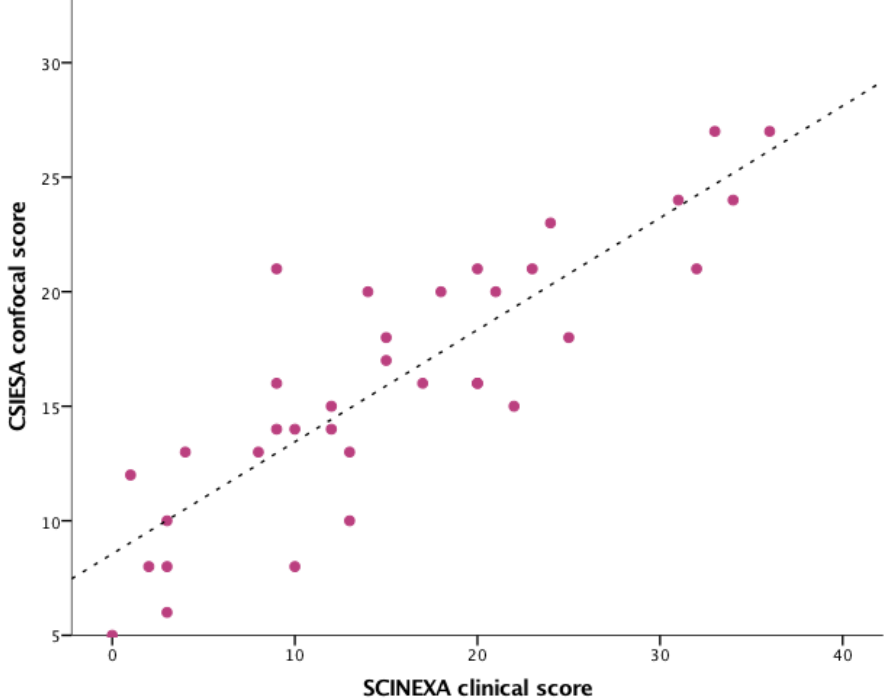
Figure 10. The correlation between SCINEXA clinical score and CSIESA confocal score.